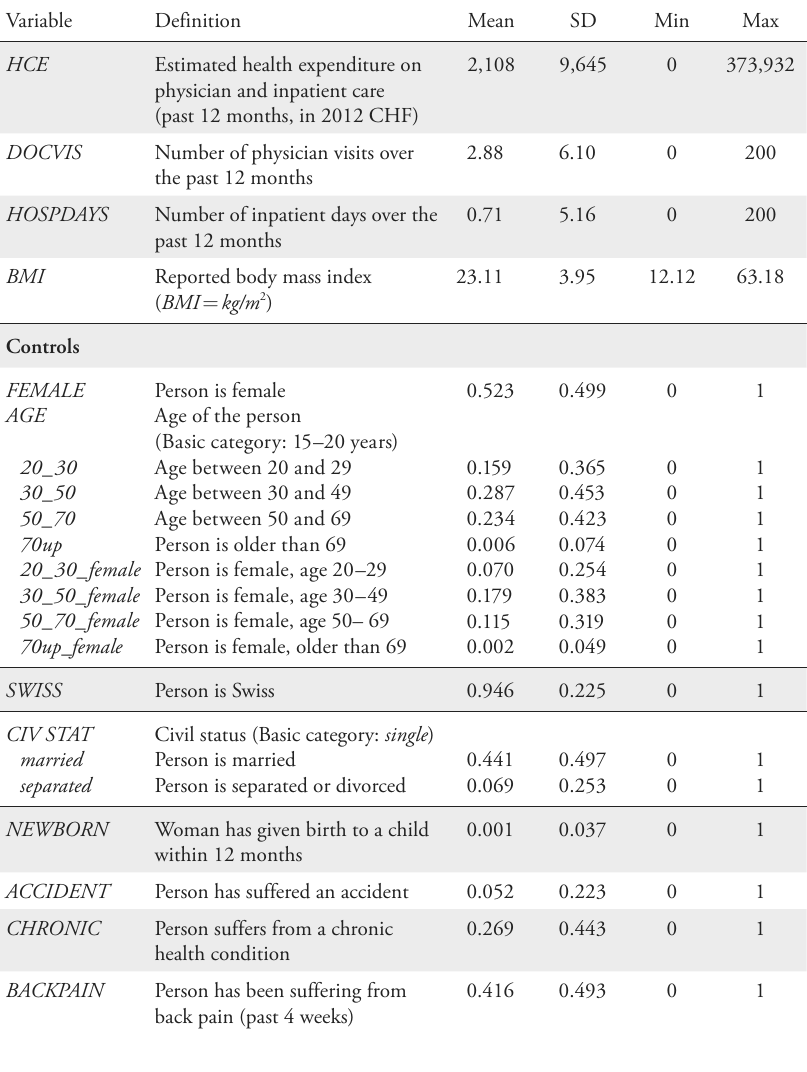
Table 5: Descriptive Statistics of all